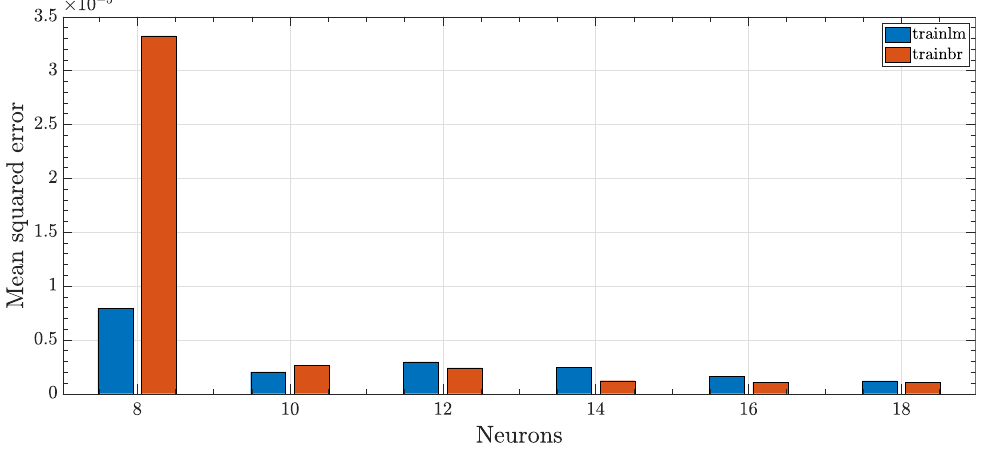
Figure 12. Single hidden layer networks performance as function of neurons and training function, sampling mode